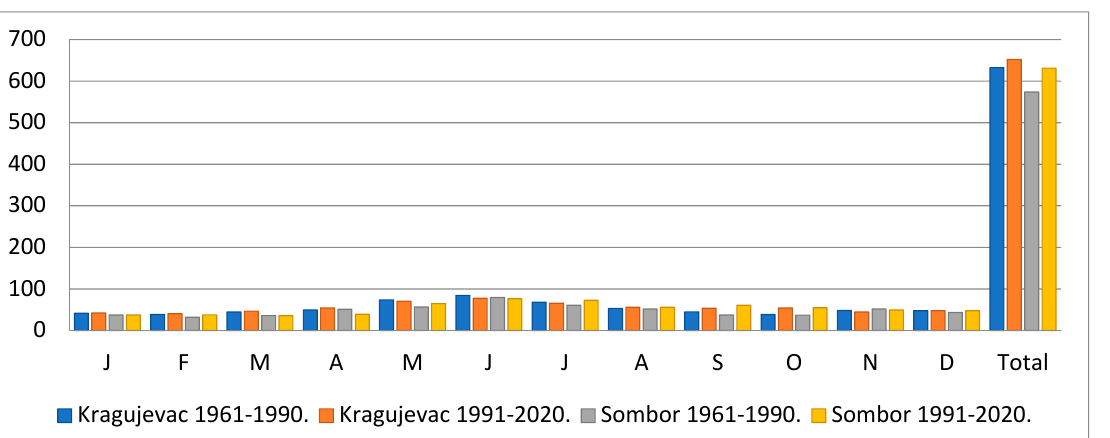
Figure 5. Amount of precipitation per month and average amount per year in Kragujevac and Sombor for the periods1961–1990 and 1991–2020.